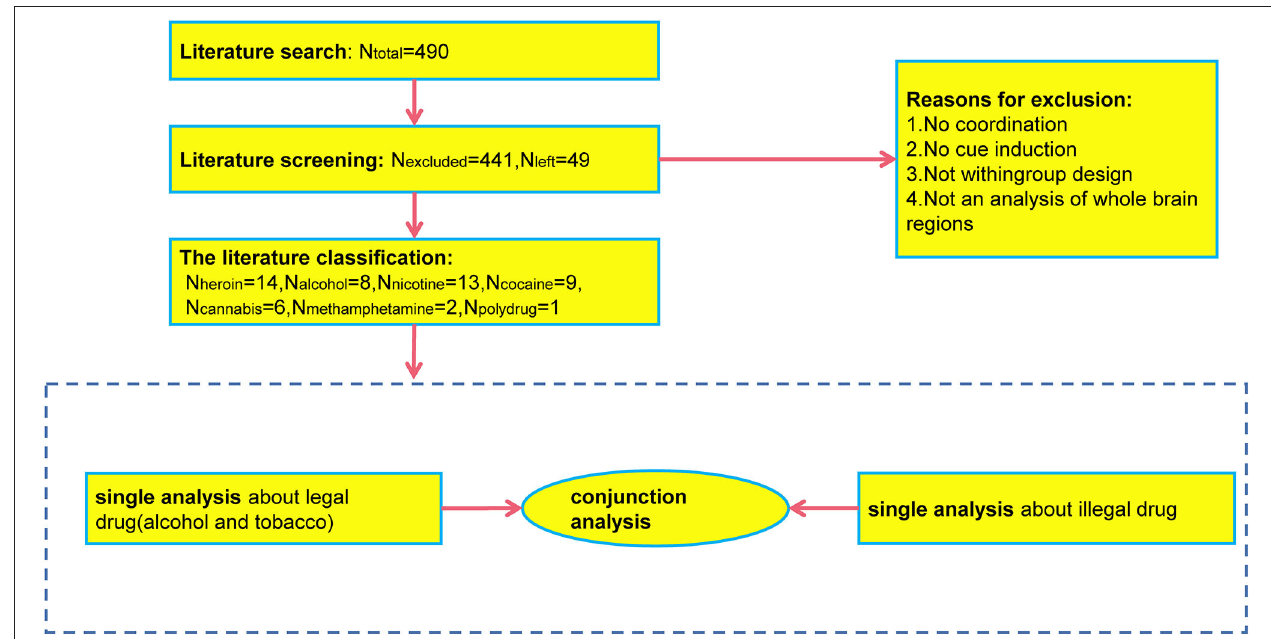
FIGURE 1 | ALE meta-analysis